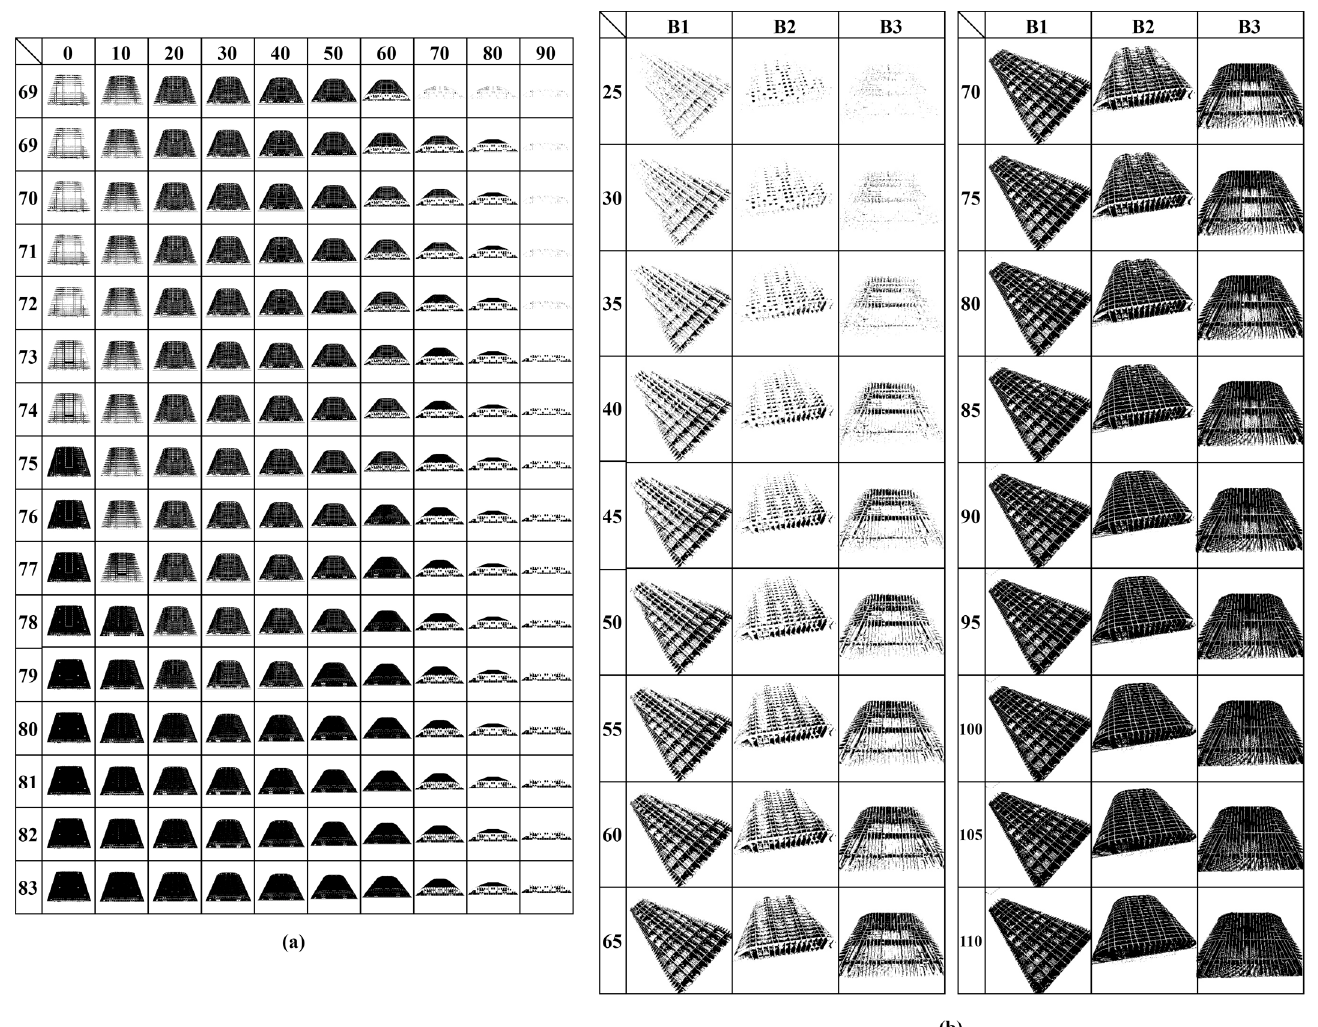
Figure 5. Thr training and testing dataset images: ( a ) B2 block training images by threshold. Axis X is an angle and axis Y is a threshold; ( b ) Testing images by threshold.